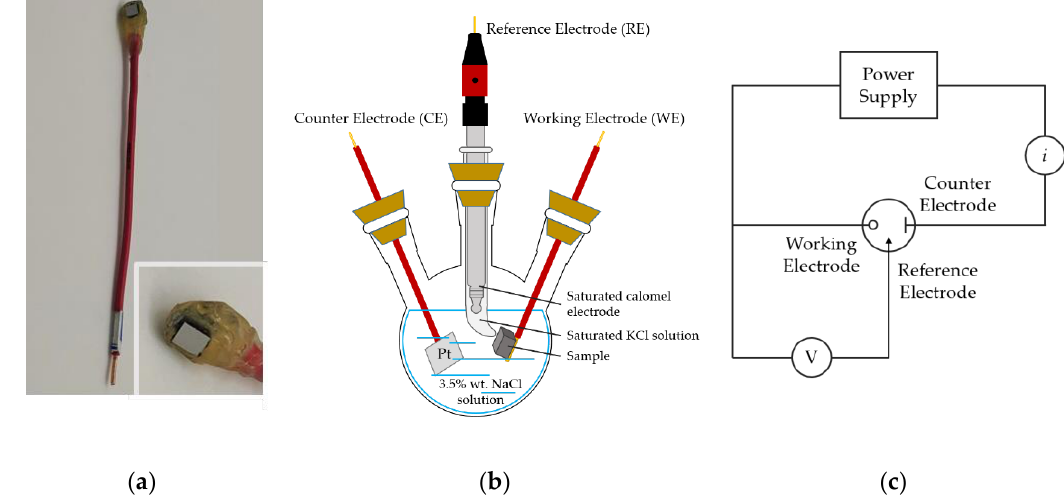
Figure 1. Device with sample (WE) used in electrochemical testing ( a ), the schematic diagram of the working device ( b ) and the test circuit diagram ( c